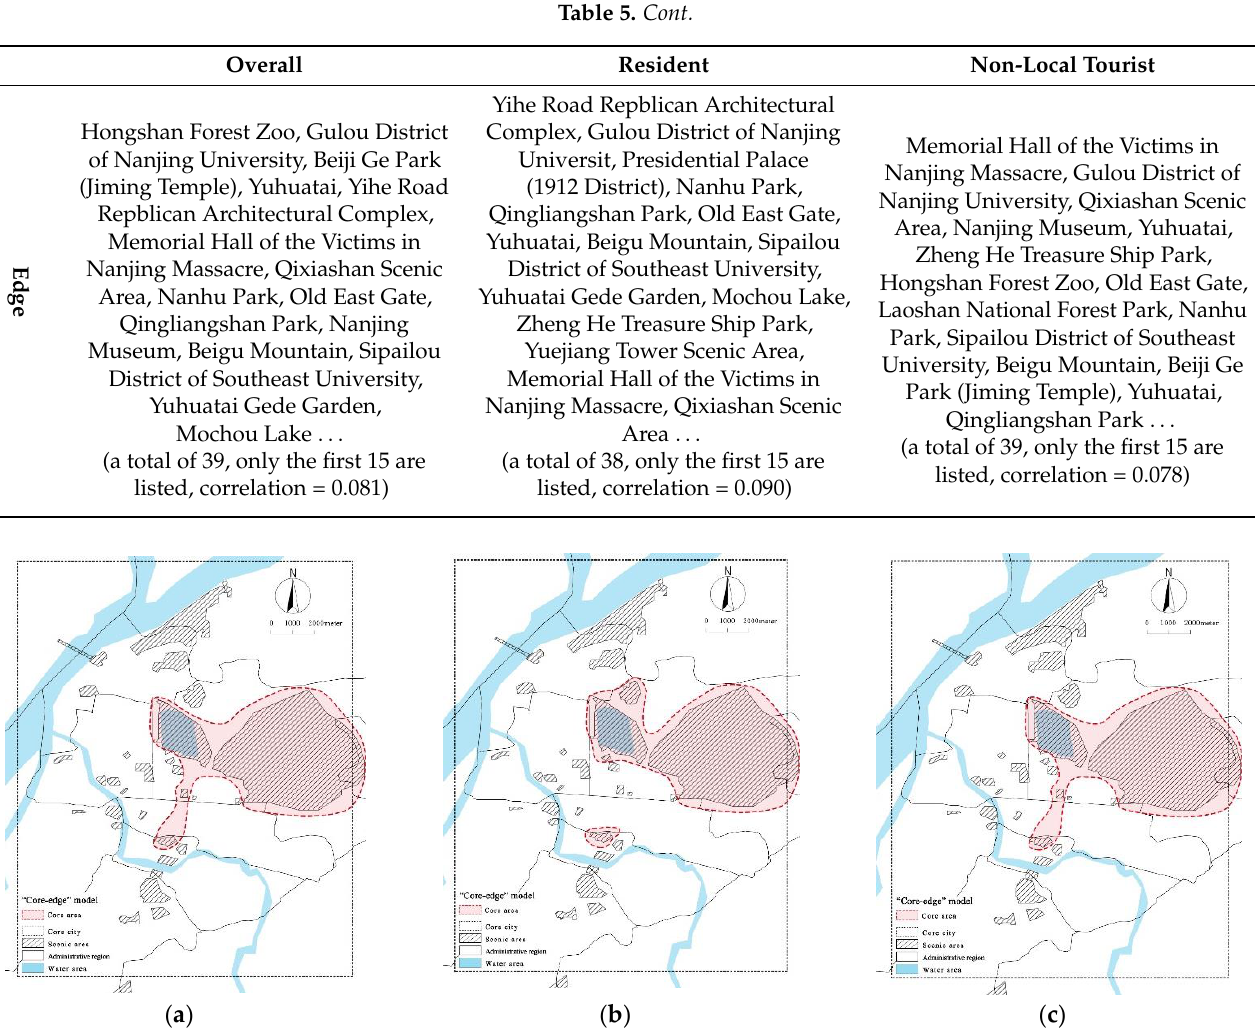
Figure 12. “Core-edge” model spatial distribution under three types of network context (overall, resident and, non-local tourist): ( a ) overall “core-edge” model of core city; ( b ) resident “core-edge” model of core city; ( c ) non-local “core-edge” model of core city.